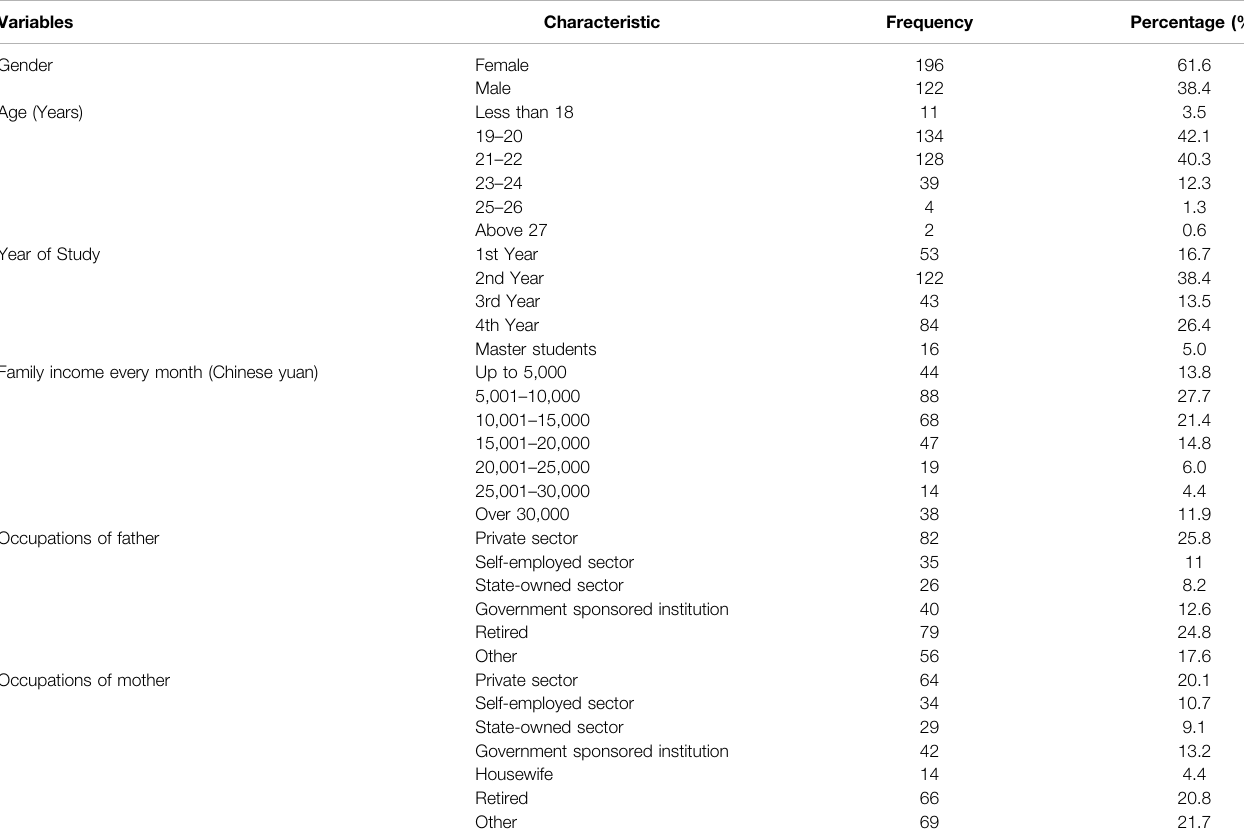
TABLE 2 | Demographics of participants in this study. Variables